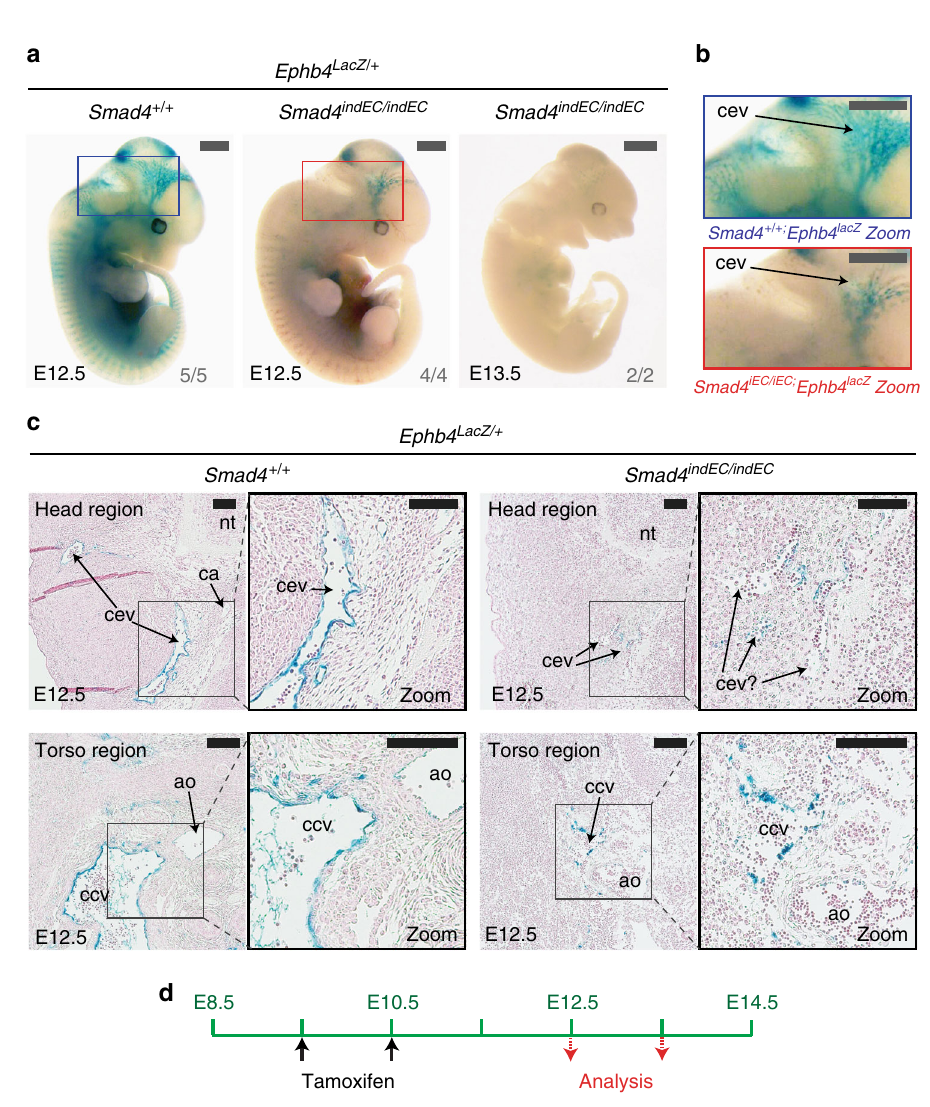
Fig. 2 Induced endothelial-speci fi c deletion of Smad4 after E9.5 results in reduced Ephb4 expression and dysfunctional venous structures. a – c Representative whole-mount images ( a ), zoomed head region images ( b ) and transverse sections through head and torso regions ( c ) from Smad4 + / + and Smad4 indEC/indEC embryos also transgenic for the venous marker Ephb4 LacZ . Embryos investigated three and four days after tamoxifen induction at E9.5 and E10.5; Smad4 + / + control for E13.5 embryos is shown in Supplementary Fig 2b. Ephb4 LacZ expression was greatly decreased in Smad4 indEC/indEC embryos compared to wild-type (WT) control at E12.5 (WT n = 5, null n = 4 from two litters) and near-ablated in Smad4 indEC/indEC embryos by E13.5 ( n = 2 from one litter). Grey scale bars are all 1000 μ m, black scale bars are all 100 μ m. d Schematic detailing tamoxifen regime and timing. Blue and red boxes denote zoomed region, numbers on bottom right-hand corner of each whole-mount image denote the number of embryos similar to picture shown. indEC indicates CDH5(PAC):Cre/ERT2-mediated deletion, + / + indicates Cre − . cev = branches of cerebral venous plexus, ca = cerebral artery, ccv = common cardinal vein, ao = aortal, nt = neural tube. See also Supplementary Figure